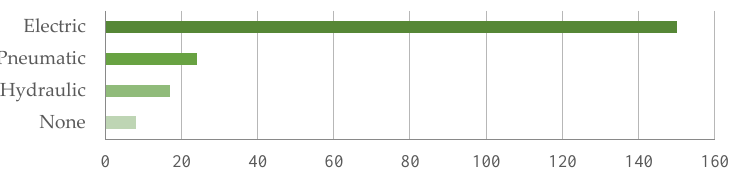
Figure 16. The distribution of exoskeletons by power source. Electric power source (73%) is un- doubtedly the most used. Pneumatics is adopted in the 13% of the revised works and hydraulics in 9%.